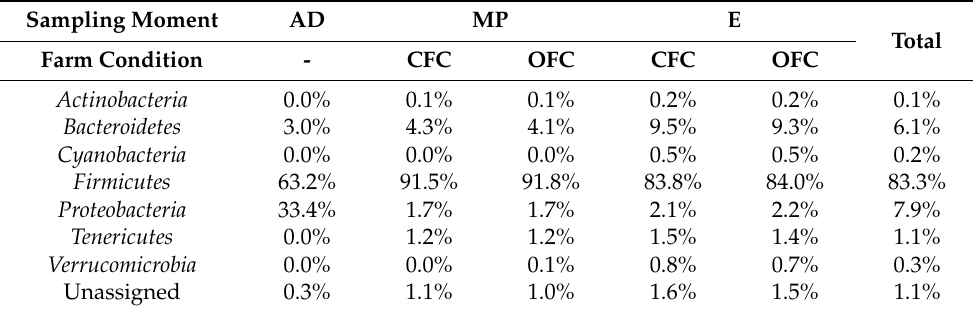
Table 3. Taxonomic profiles at phylum level according to sampling moment in commercial (CFC) and optimal (OFC) farm